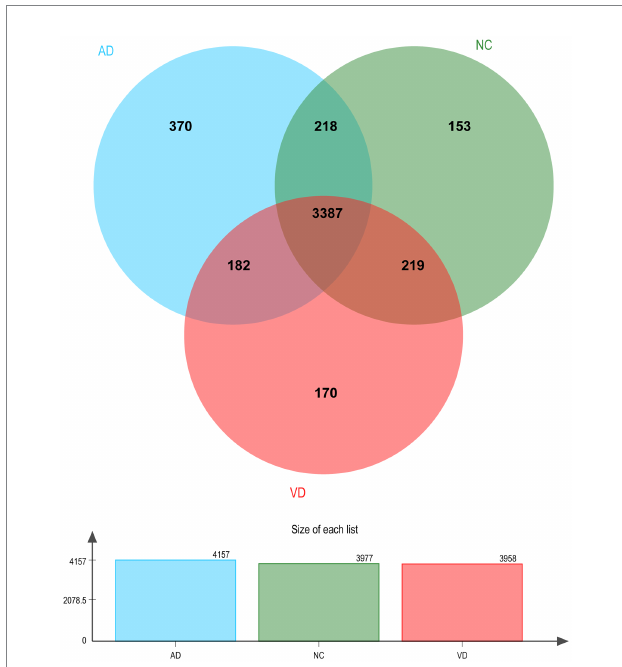
FIGURE 2 Venn diagram illustration of Urine proteins identified in VD, AD, and NC group, respectively. Representative Venn diagrams showing common proteins found in pooled urine-enriched fractions from VD patients ( n = 14), AD patients ( n = 9), and NC group ( n =